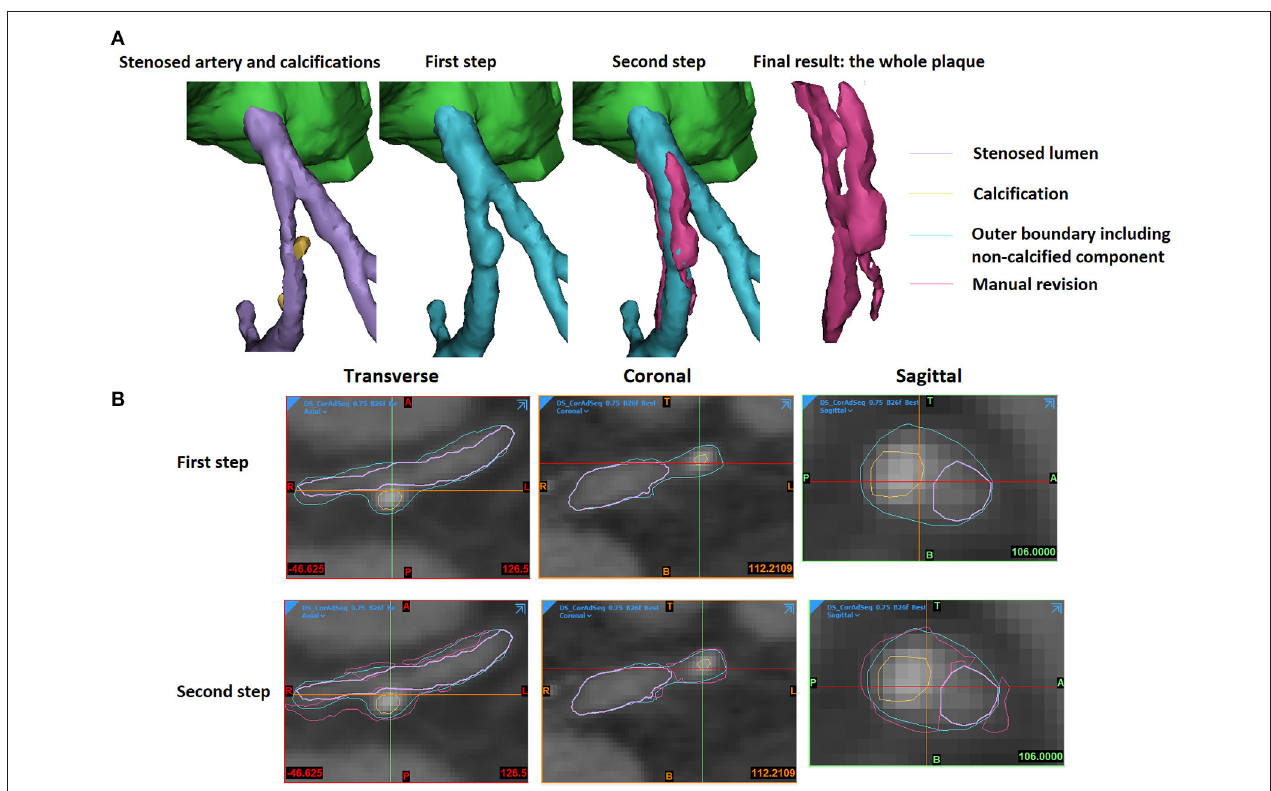
FIGURE 2 | The extraction of an atherosclerotic plaque. (A) The 3D view. (B) The 2D views. The stenosed artery lumen, calcification, outer boundary that wraps vessel lumen and non-calcified components, as well as the manually revised results were shown in purple, yellow, cyan, and magenta colours in the 3D and 2D